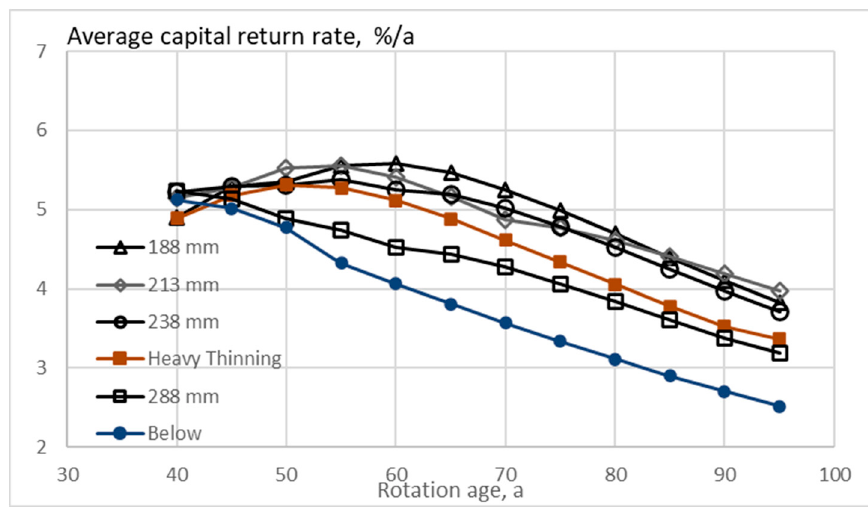
Figure 3. The expected value of capital return rate for six different treatment schedules applied on a normal stand representing the example estate. The capital return rate is integrated according to Equation (7) over stand age until any rotation age. The clearcutting price premium is applied within the terminal 30 months, as well as clearcutting harvesting pricing.